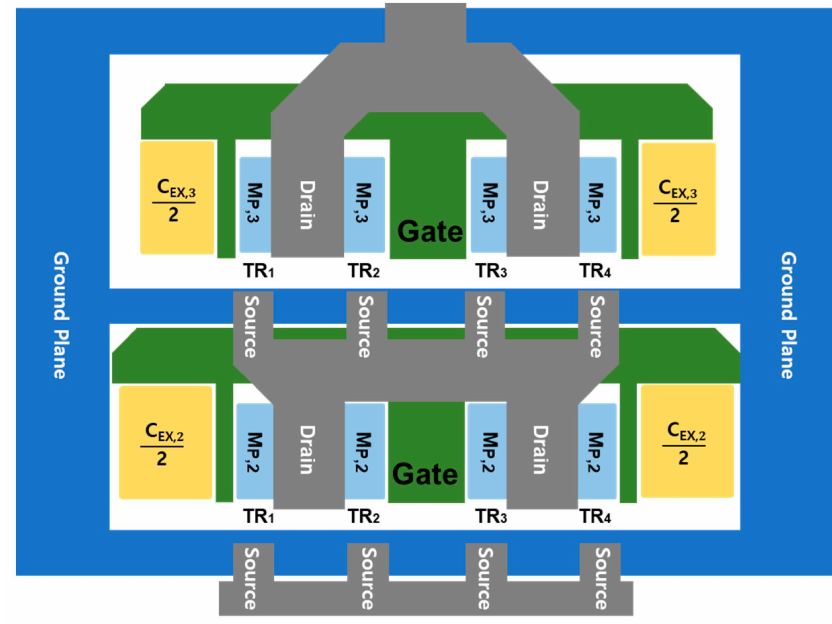
Figure 10. Layout of the power transistor with proposed split external gate